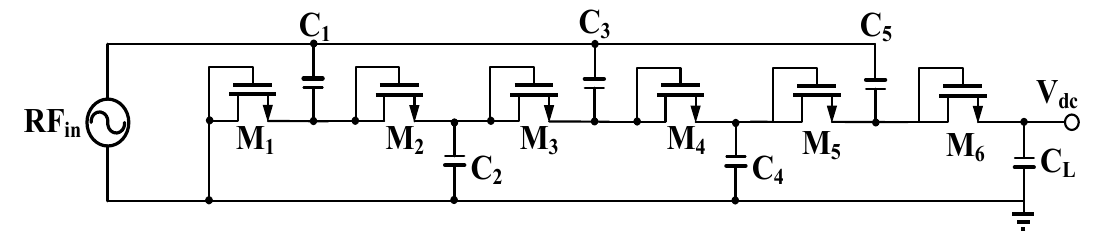
Figure 3. Six-stage Dickson voltage multiplier circuit.